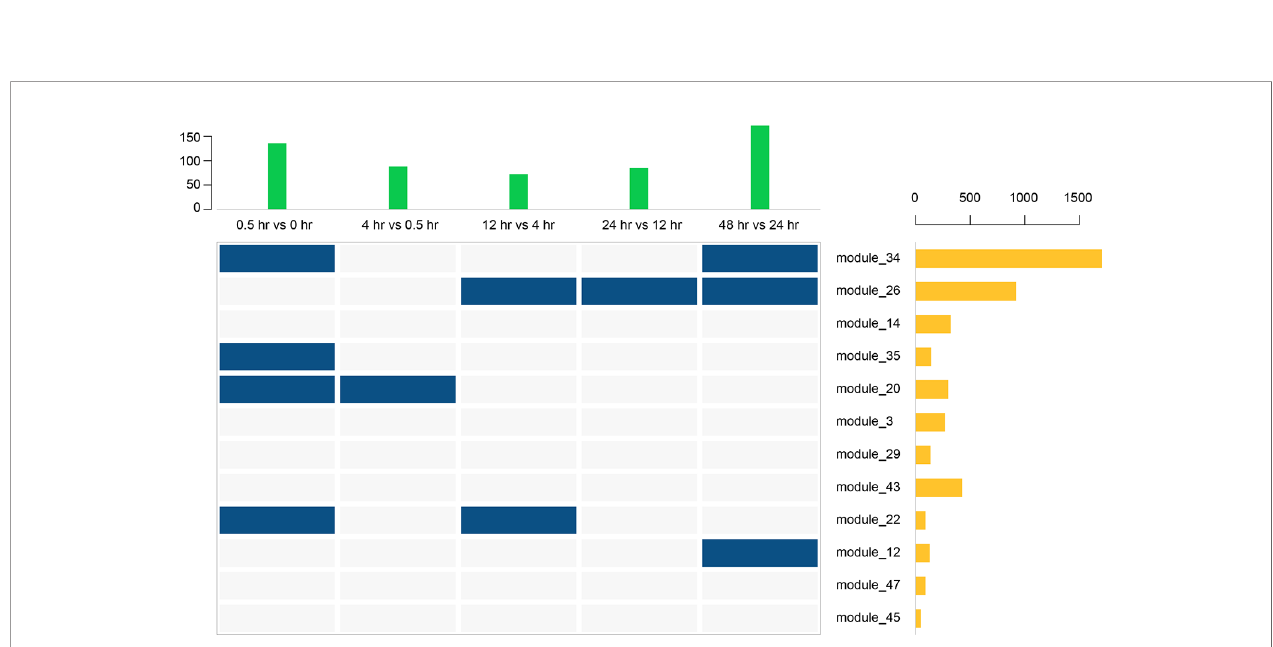
FIGURE 8 | PCA analysis of 12 gene modules. The X axis represents time period, and the Y axis represents expression of fi rst principal component.